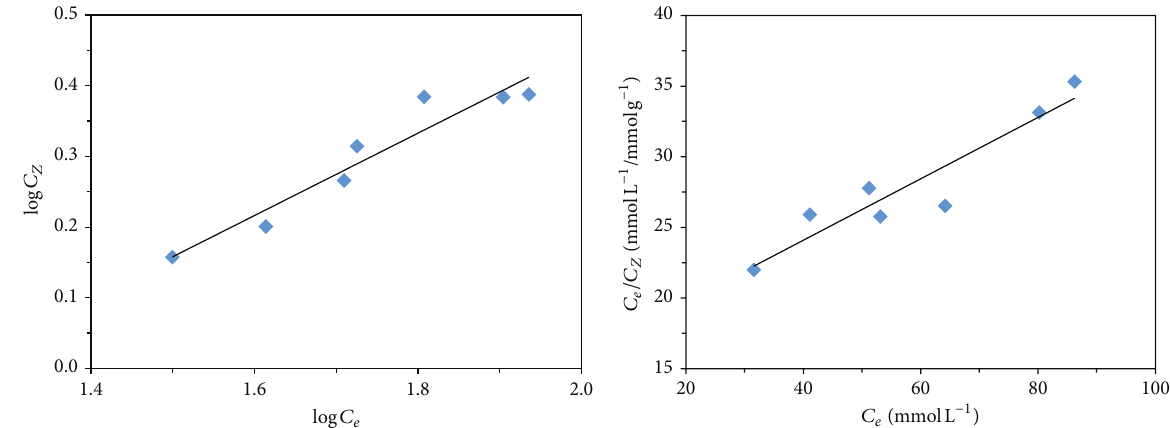
Figure 2: Freundlich sorption and Langmuir sorption isotherm of cobalt (II) at pH =